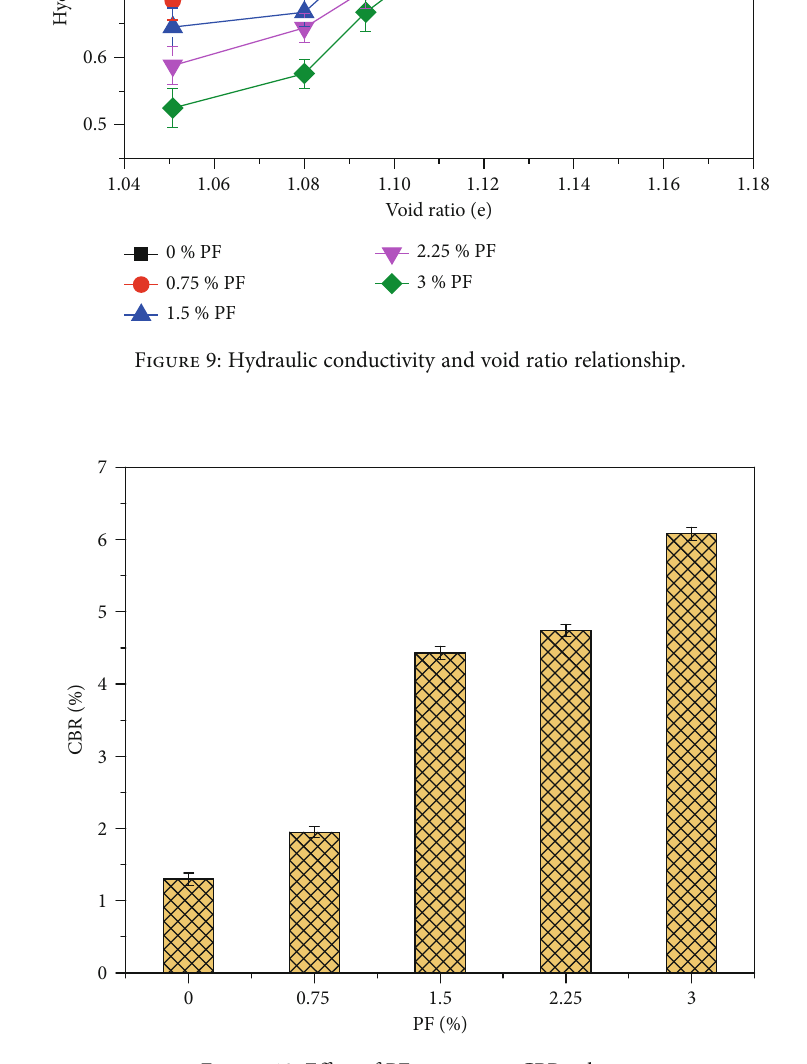
Figure 10: E ff ect of PF content on CBR